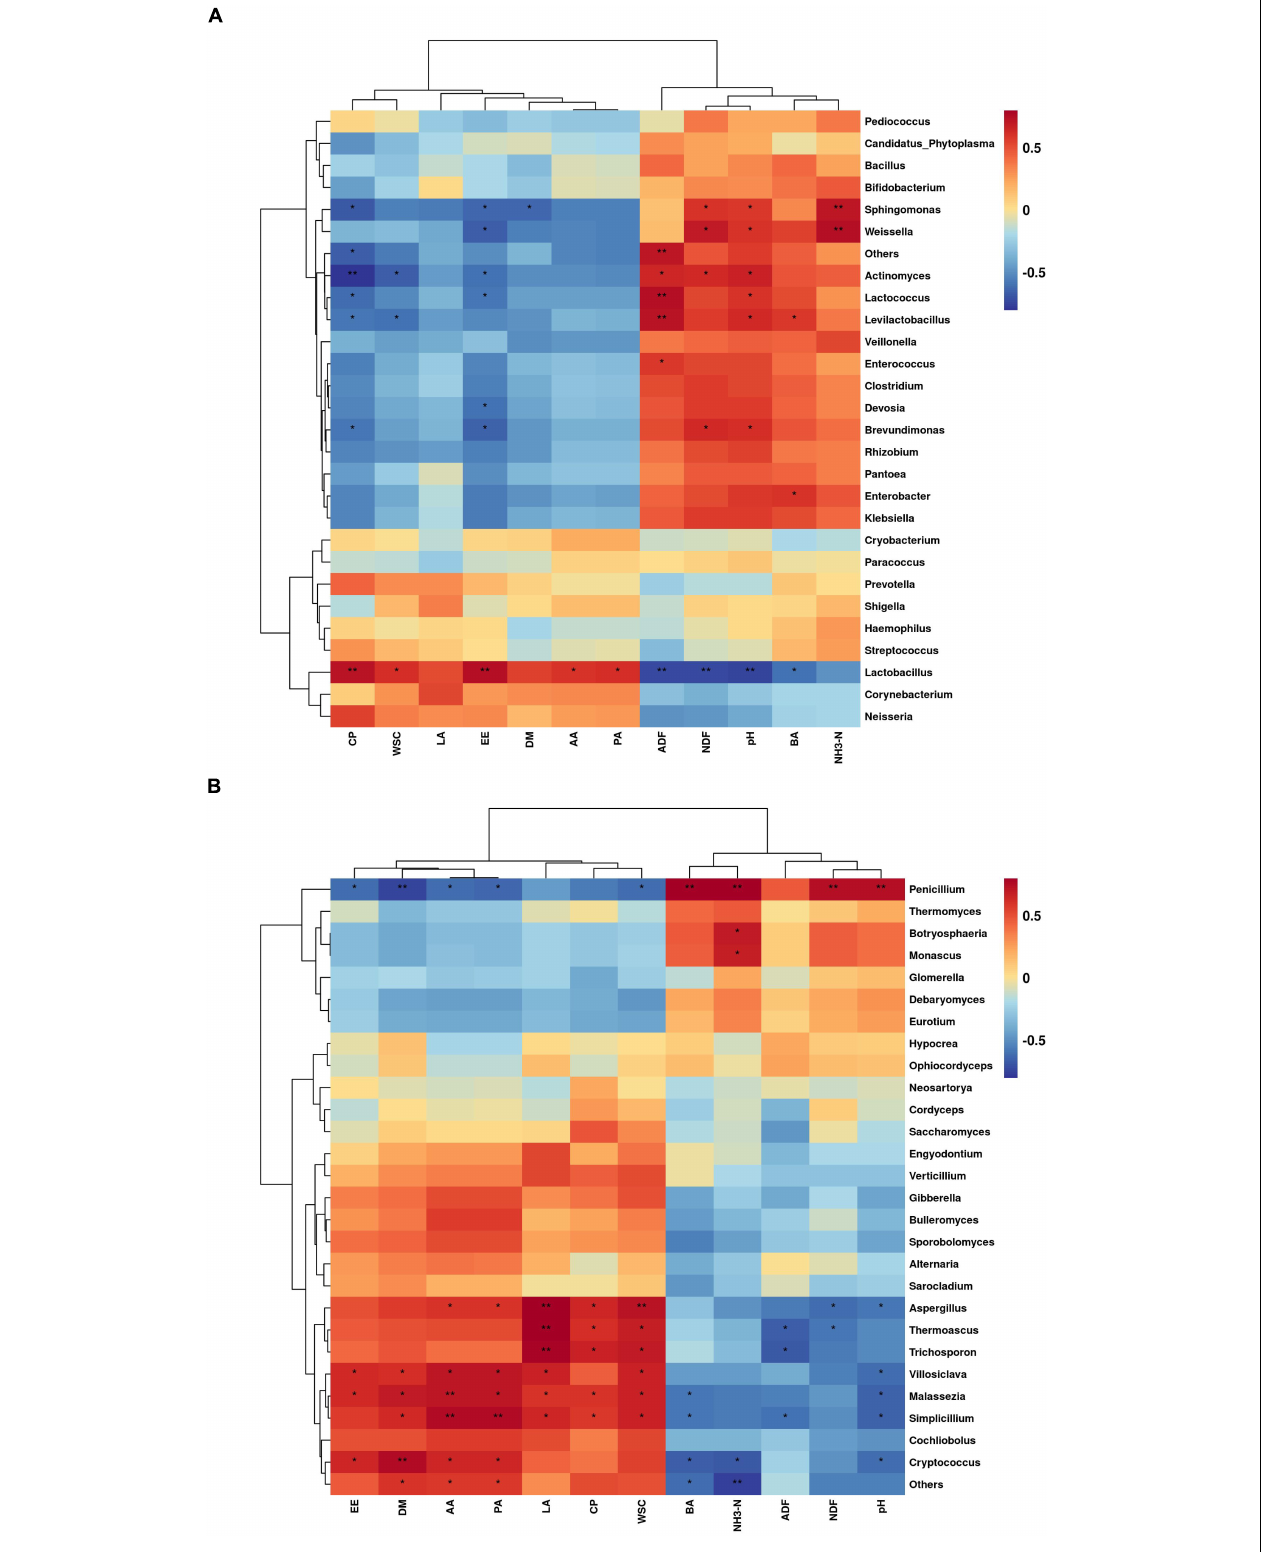
FIGURE 5 | Correlation of bacterial genera level (A) and fungal genera level (B) with silage quality during aerobic exposure of silage (* P < 0.05; ** P < 0.01).